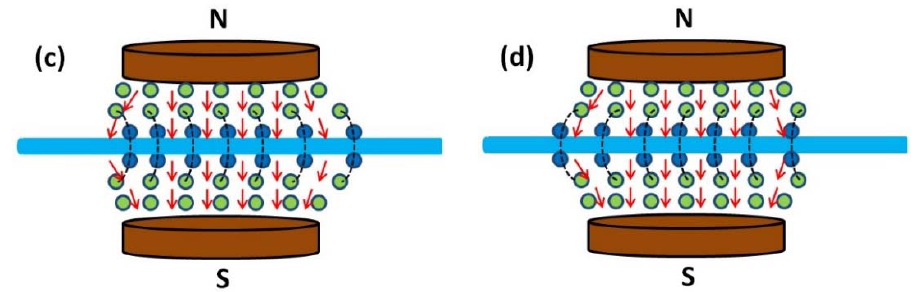
Figure 6. The arrangement state of particles when the magnetic field is applied ( b – d ) or not ( a ); ( b ) the catheter was not moved; ( c ) the catheter was moved forward; ( d ) the catheter was moved backward.